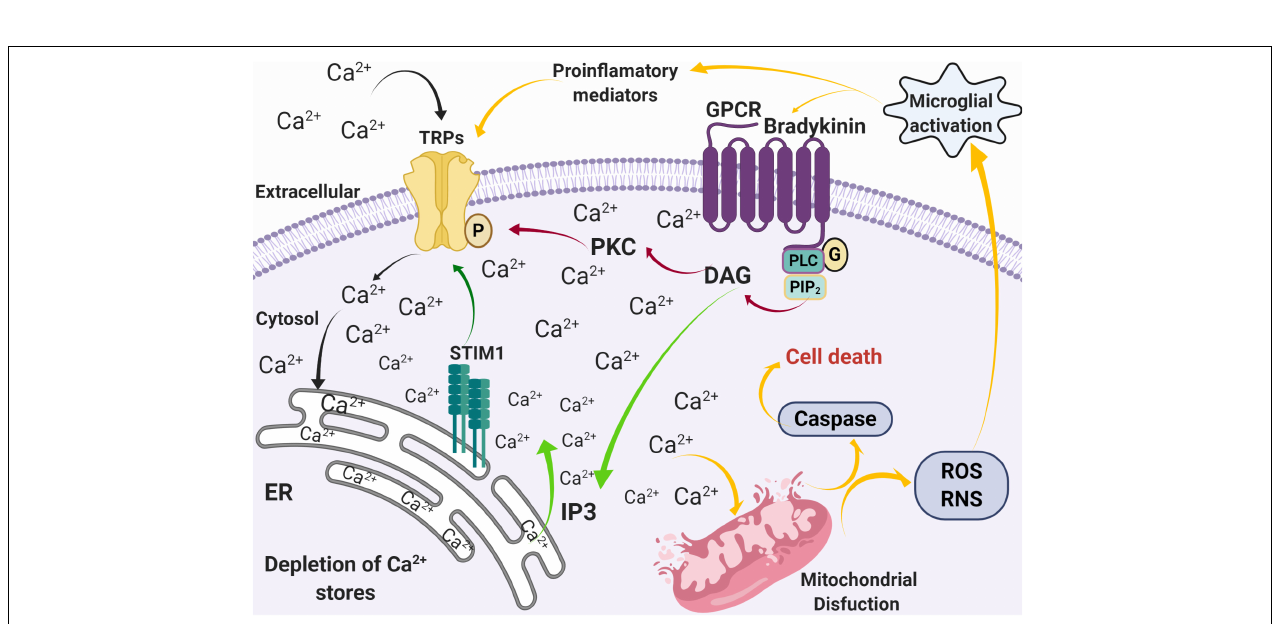
FIGURE 3 | Alterations in calcium homeostasis mediated by SOCE during inflammation and oxidative stress. Activation of G-coupled receptors by pro-inflammatory mediators, such as bradykinin, induces the release of Ca 2 + from the ER stores through the PLC pathway (green arrows), followed by an influx of Ca 2 + through Ca 2 + permeable channels such as TRPs (black arrows). The increase [Ca 2 + ]i then induces mitochondrial dysfunction that leads to caspase activation, ROS and RNS production, microglia activation, and production of pro-inflammatory mediators (yellow arrows).